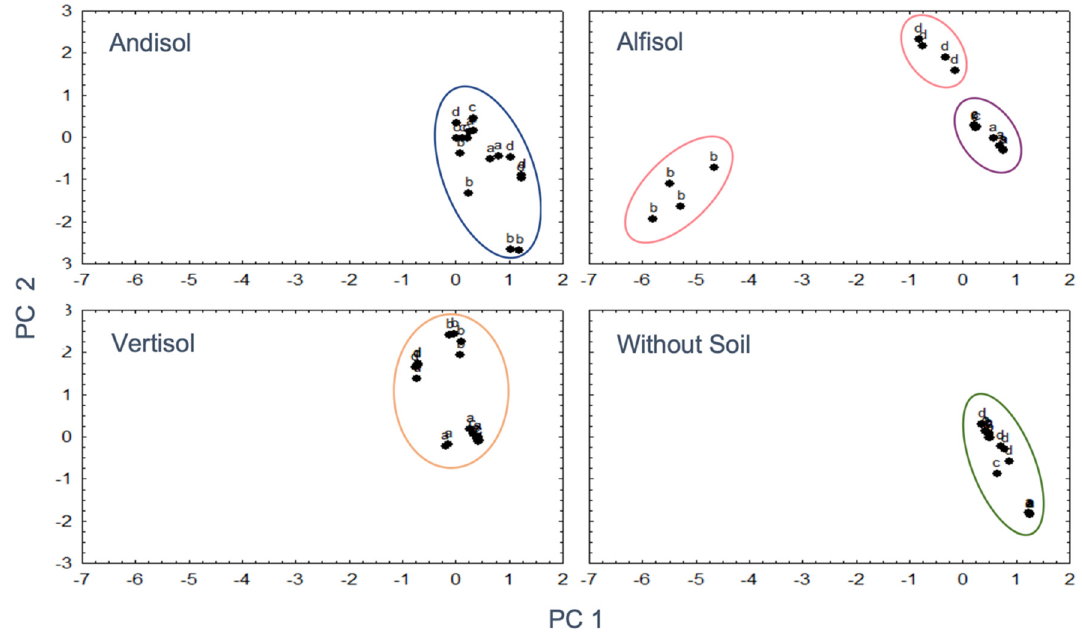
Figure 4. Distribution patterns of fungal isolates in the four different soil types. It was observed that except in Alfisol, the fungal isolates did not display much variability between them, which results in a strong grouping. Ellipses demonstrate microorganism community groups a: BMH-0059, b: BMH-0060, c: BMH-0061, d: BMH-0062.